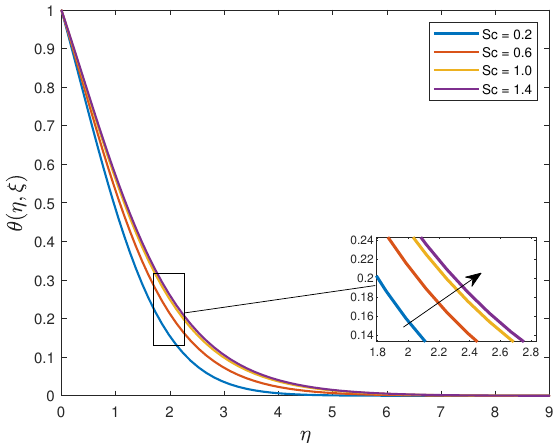
Figure 11. The influence of Sc on fluid